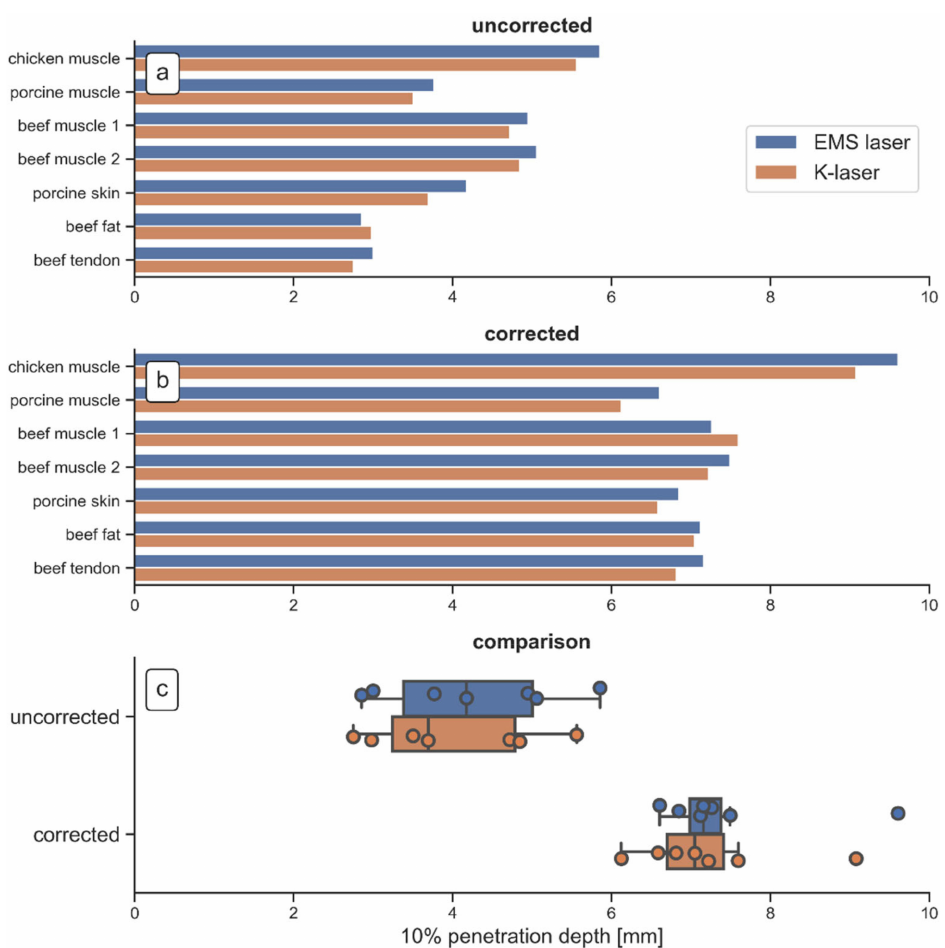
Figure 6. 10% penetration depths of the EMS laser (blue bars) and the K-laser (orange bars) for all measured tissues: uncorrected penetration depth ( a ); penetration depth after correction for reflection losses ( b ); comparison of the uncorrected and the corrected 10% penetration depth (Tukey boxplots of all data shown in ( a , b )) ( c